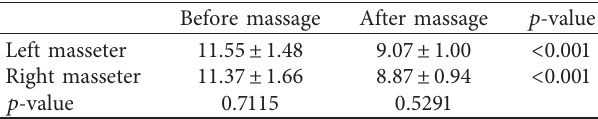
Table 1: Elasticity values before and after massage (data are shown in